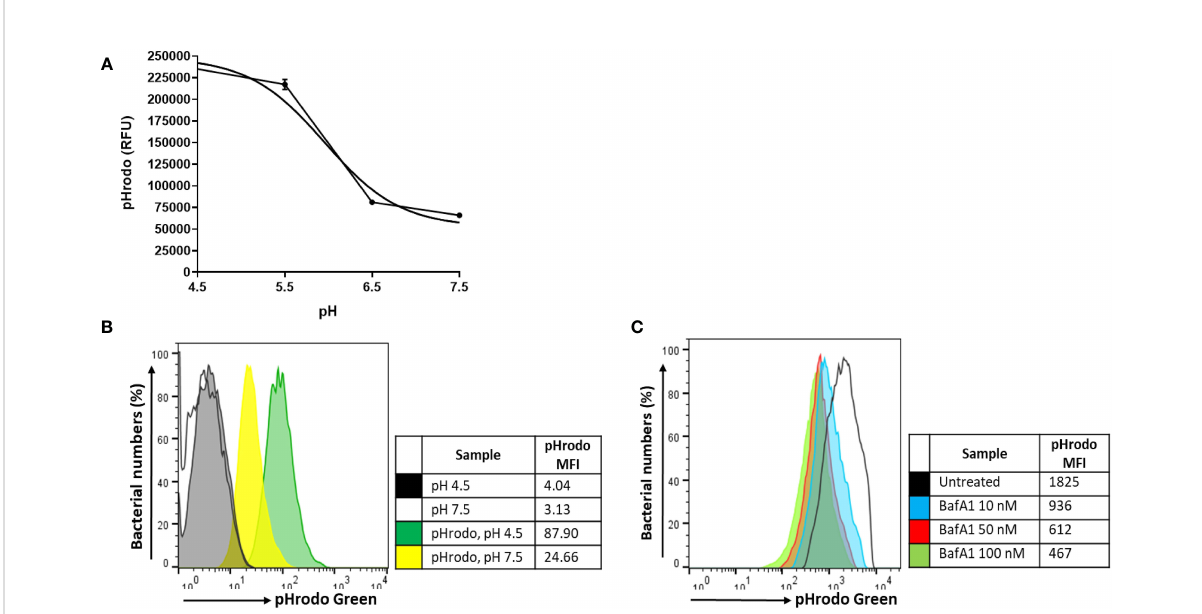
FIGURE 6 pH calibration of pHrodo Green. (A) Exponentially growing M. tuberculosis D leuD D panCD:: pSTCHARGE was labelled with 0.5 mM pHrodo Green, exposed to potassium phosphate buffers ranging between pH 4.5-7.5, and visualized spectrophotometrically. A sigmoidal line of best fi t was applied to the graph using GraphPad Prism, generating a pH lookup table to accurately determine the pH (Supplementary Table 2). Results are representative of triplicate samples, displaying geometric mean ± SD, and involved the removal of background fl uorescence from unstained cells. (B) Un fi xed macrophages infected with unlabelled or pHrodo-labelled M. tuberculosis D leuD D panCD ::pSTCHARGE pre-induced with 4 mM theophylline were harvested and exposed for 60 min to pH 4.5 and pH 7.5 potassium phosphate buffers to determine whether a change in intracellular fl uorescence could be observed using fl ow cytometry. The increase in pHrodo MFI re fl ects the decrease in pH. (C) Macrophages were pre-treated with increasing concentrations of BafA1 40 min prior to infection with pHrodo-labelled M. tuberculosis D leuD D panCD ::pSTCHARGE pre-induced with 4 mM theophylline. Intact macrophages were harvested following internalization and resuspended in HBSS buffer (un fi xed) prior